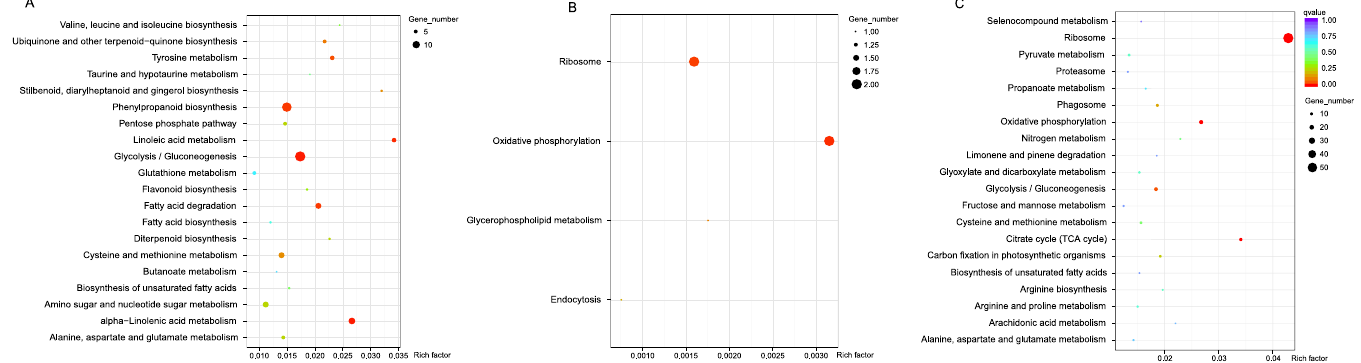
Fig 5. KEGG enrichment analysis of DEGs from the three treatments. (A)Treatment vs control; (B) Treatment vs recovery; (C) Recovery vs control. The vertical axis contains multiple pathways, and the horizontal axis represents the enrichment factor corresponding to individual pathways. The size of the q-value is represented by the color of the dot, with smaller q- values depicted in red and larger q- values in blue. The number of differential genes contained in each pathway is represented by the size of the dot.